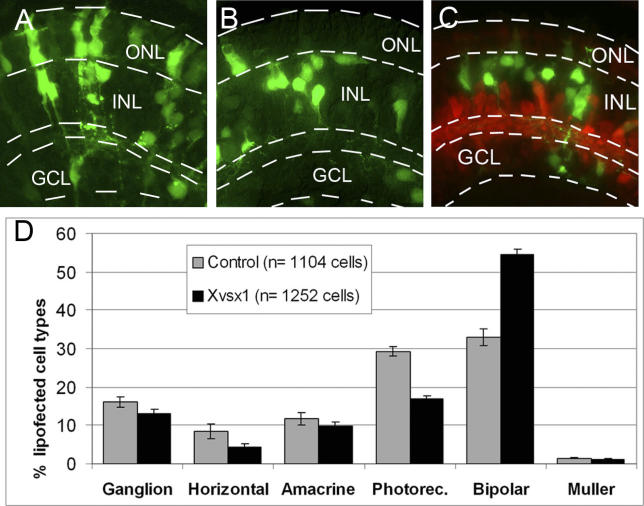
The Xenopus Xvsx1 Homeobox Gene Supports Bipolar Cell Fate(A–C) Sections of st. 42-lipofected retinas. GFP (green) traces lipofection. (A) Example of control lipofection. (B and C) Example of Xvsx1 lipofection. (C) Immunostaining (red fluorescence) with amacrine antibodies panel (anti-5-HT, anti-GABA, anti-tyrosine hydroxilase), labeling the main classes of amacrine cells at this developmental time [47,48] ONL: outer nuclear layer; INL: inner nuclear layer; GCL: ganglion cell layer. Xvsx1 lipofection (B) increases the proportion of INL cells and decreases the proportion of ONL cells compared to control (A). The majority of the Xvsx1-lipofected cells in the INL are not stained either by amacrine markers (C), or by the horizontal marker prox1 (not shown).(D) Statistical analysis showing the proportion of lipofected cell types. Cell types were identified as described [14]. Error bars indicate standard error of the mean. Xvsx1 misexpression increases the proportion of bipolar cells (from 33% of control to 55%, student's t-test, p = 0.000043), mainly at the expense of photoreceptors (from 29% to 14%, student's t-test, p = 0.000011).